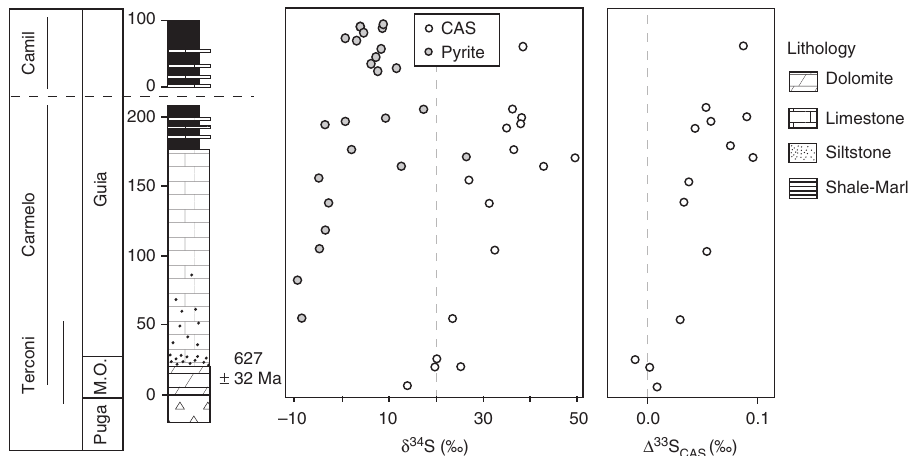
Figure 1 | Isotopic results of sedimentary carbonates of the Araras platform. Sulfur isotope composition of sulfate ( d 34 S CAS and D 33 S CAS ) and pyrite ( d 34 S pyr ) of the Araras carbonates. Results are given in % versus CTD. Terconi, Carmelo and Camil section are represented as a single composite stratigraphic log 17